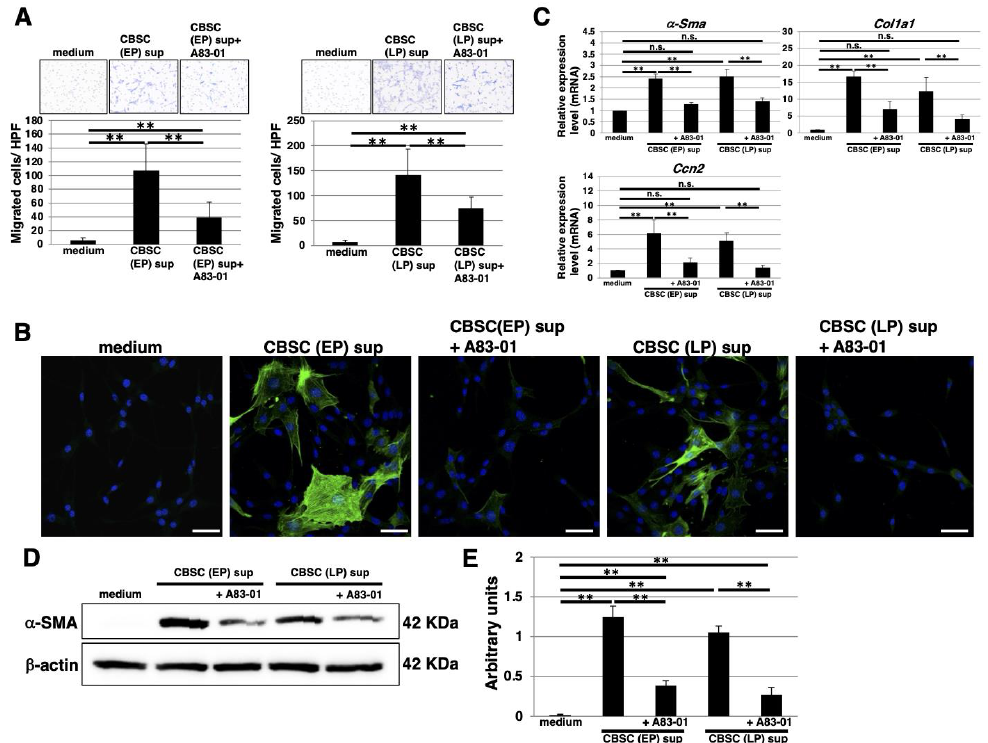
Figure 6. The functional properties of TGF- β 1 derived from mCBSCs. ( A ) Migration assays were performed in mCBSCs (EP and LP). CBSCs growth media, mCBSCs culture media, or mCBSCs culture media with 1 µ M A83-01 was used for chemoattractant. Representative results from measurements of 12 fields are shown. ** p < 0.01. ( B ) Immunocytochemical staining was performed in NIH/3T3 cells cultured with CBSCs growth media, mCBSCs culture media, or mCBSCs culture media with 1 µ M A83-01. Representative images are shown ( α -SMA, green ; DAPI, blue ). Scale bar in the image: 50 µ m. ( C ) Real-time PCR analysis of α -Sma , Col1a1 , and Ccn2 in NIH/3T3 cells cultured with CBSCs growth media, mCBSCs culture media, or mCBSCs culture media with 1 µ M A83-01. The results are shown after normalization against the values obtained for NIH/3T3 cells cultured with CBSCs growth media (value = 1). The values shown are the means ± SD from three independent experiments. ** p < 0.01, n.s.: not significant. ( D ) Western blot analysis of α -SMA and β -actin (loading control) was performed in NIH/3T3 cells cultured with CBSCs growth media, mCBSCs culture media, or mCBSCs culture media with 1 µ M A83-01. The blot images were cropped to highlight the α -SMA and β -actin bands. ( E ) The histogram shows the mean densitometric analysis ± SD of α -SMA normalized to the loading control ( β -actin). The values were obtained from three independent experiments. ** p < 0.01. Abbreviations: mMSC, mouse mesenchymal stem cell; mCBSC, mouse cortical-bone-derived stem cell; EP, early passage; LP, late